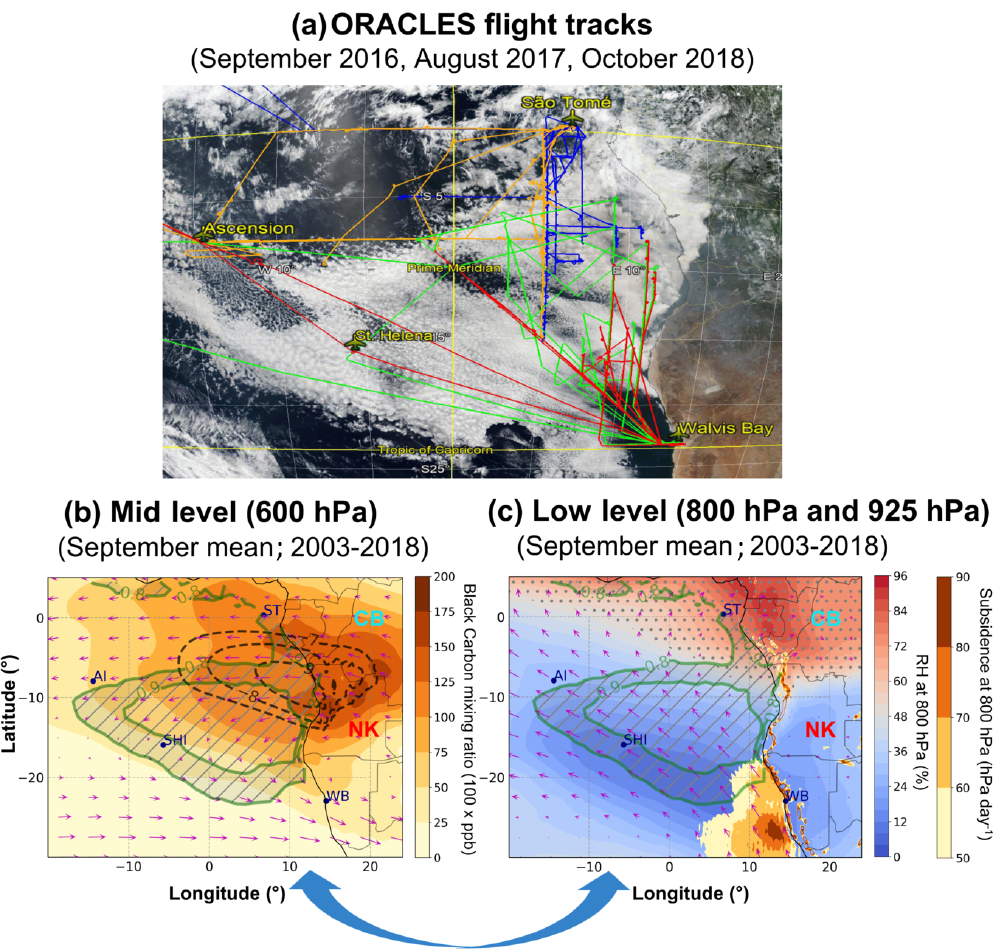
Figure 1. (a) ORACLES flight tracks in September 2016 (green for ER-2 flight; red for P-3 flight), August 2017 (orange for P-3 flight), and October 2018 (blue for P-3 flight) overlain on a MODIS Aqua true cloud image and © Google Maps on 13 September 2018 (adapted from Redemann et al., 2021). (b) Map of the September mean (2003–2018) of (a) CAMS 600hPa black carbon mixing ratio (BC; shading; parts per billion (ppb) × 100) overlaid by the ERA5 600hPa zonal wind (black contours; − 7, − 8, and − 9ms − 1 ), 600hPa horizontal wind vector (magenta; ms − 1 ), and low-cloud fraction (low CF; green contours; 0.8, 0.9). (c) The same as panel (a) , except for 800hPa relative humidity (RH; gray hatch as dot; RH > 50, %) overlaid by 800hPa omega (shading; a positive value is subsidence; hPad − 1 ), 925hPa horizontal wind vector (magenta; ms − 1 ), and low CF (green contours; 0.8 and 0.9) over the ORACLES deployment region in the SE Atlantic Ocean. The letters represent São Tomé (ST), St. Helena island (SHI), Ascension Island (AI), and Walvis Bay (WB). CB stands for Congo basin (characterized as cool and moist areas), and NK represents Namibia–Kalahari dryland (characterized as warm and dry areas). The navy arrow indicates the coupling of aerosol and meteorology in mid- and low-level layers, affecting low-cloud